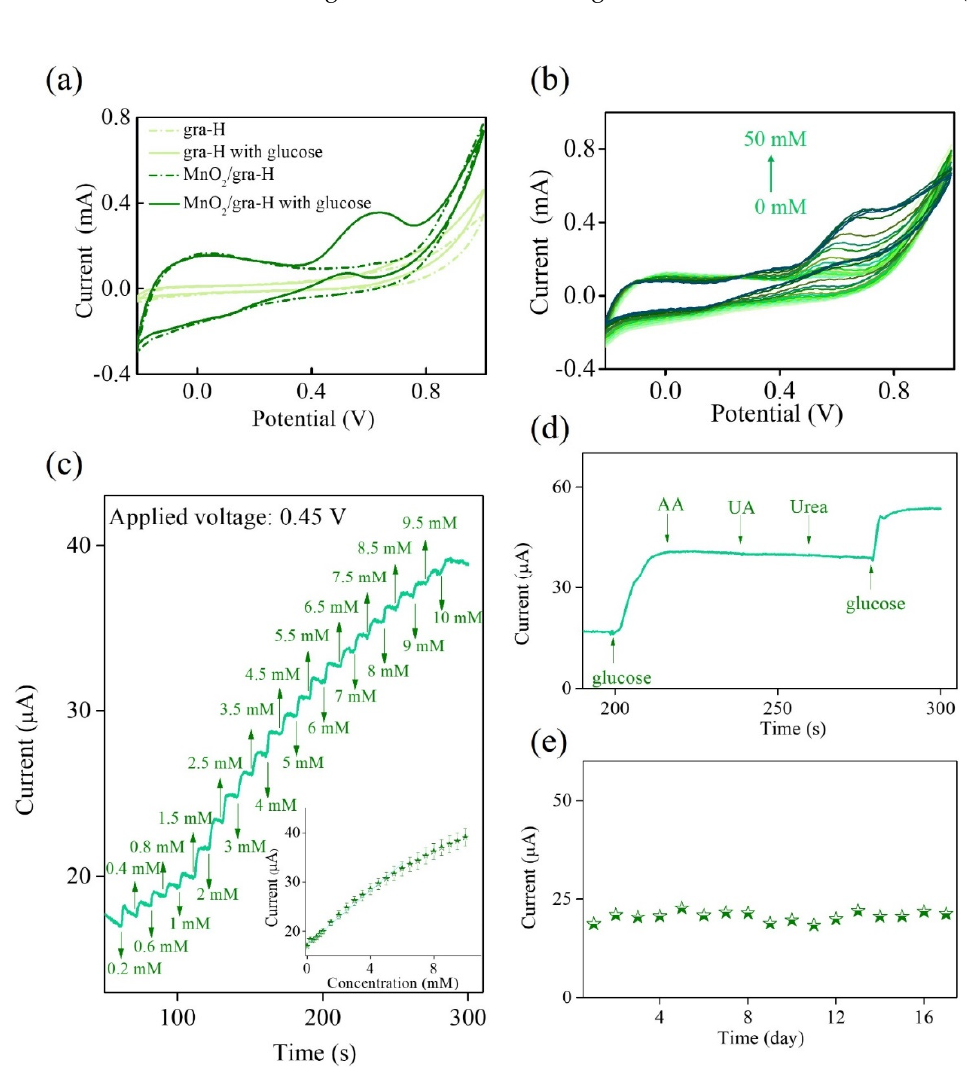
Figure 6. ( a ) CV curves of gra-H and MnO 2 /gra-H in 0.1 M NaOH in the absence (dashed lines) and presence (solid lines) of 10 mM glucose at a scan rate of 50 mV s − 1 . ( b ) CV curves of MnO 2 /gra-H in 0.1 M NaOH with successive addition of various glucose concentrations. ( c ) Amperometry of MnO 2 /gra-H in 0.1 M NaOH with successive addition of various glucose concentrations at applying voltage +0.45 V. In inset of ( c ) is the corresponding calibration plot of the response current versus glucose concentration. ( d ) Interference tests and ( e ) long-term stability of MnO 2 /gra-H in 0.1 M NaOH at applying voltage +0.45 V (denoted by green star).